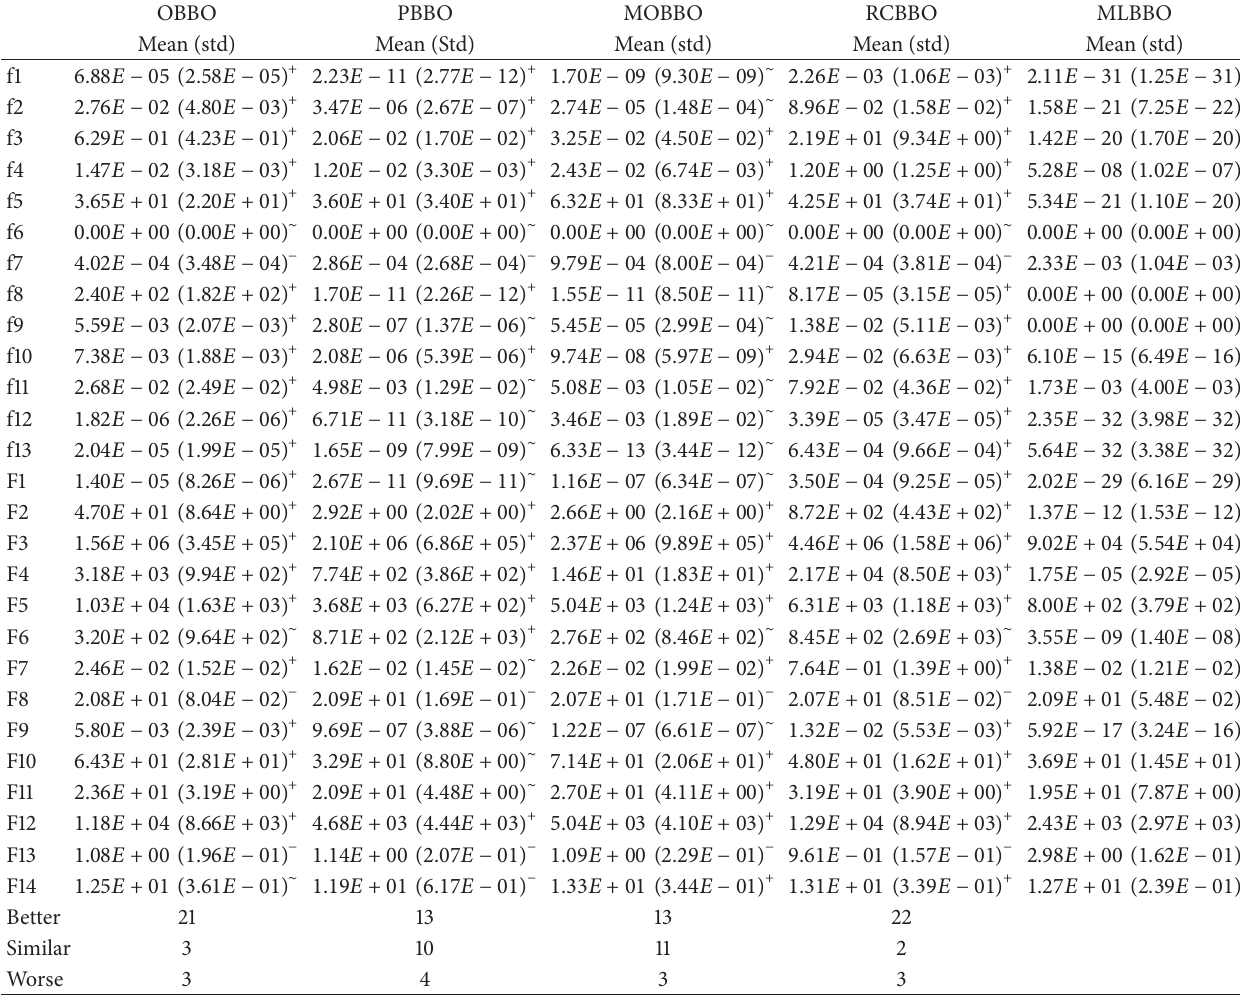
Table 3: Comparisons with improved BBO